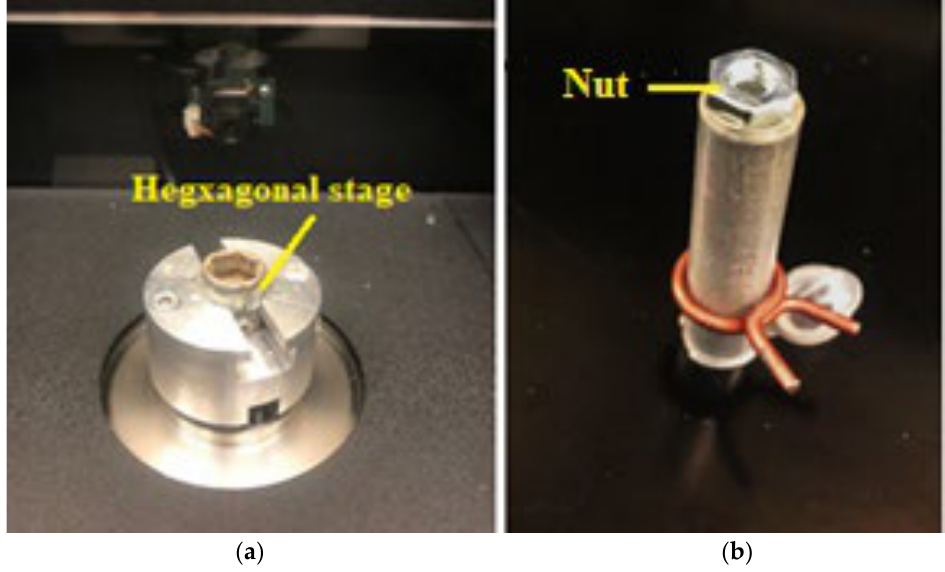
Figure 2. ( a ) Hexagonal stage; ( b ) sample by gluing a nut at the bottom. Concrete Samples Concrete Samples